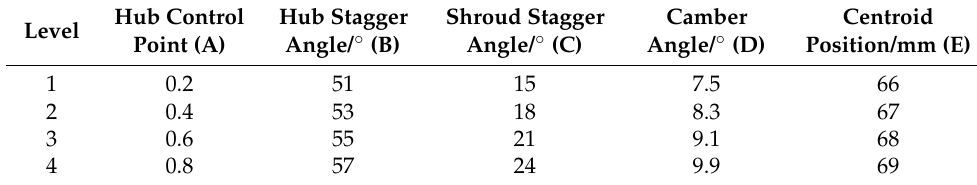
Table 2. Orthogonal parameter and level.